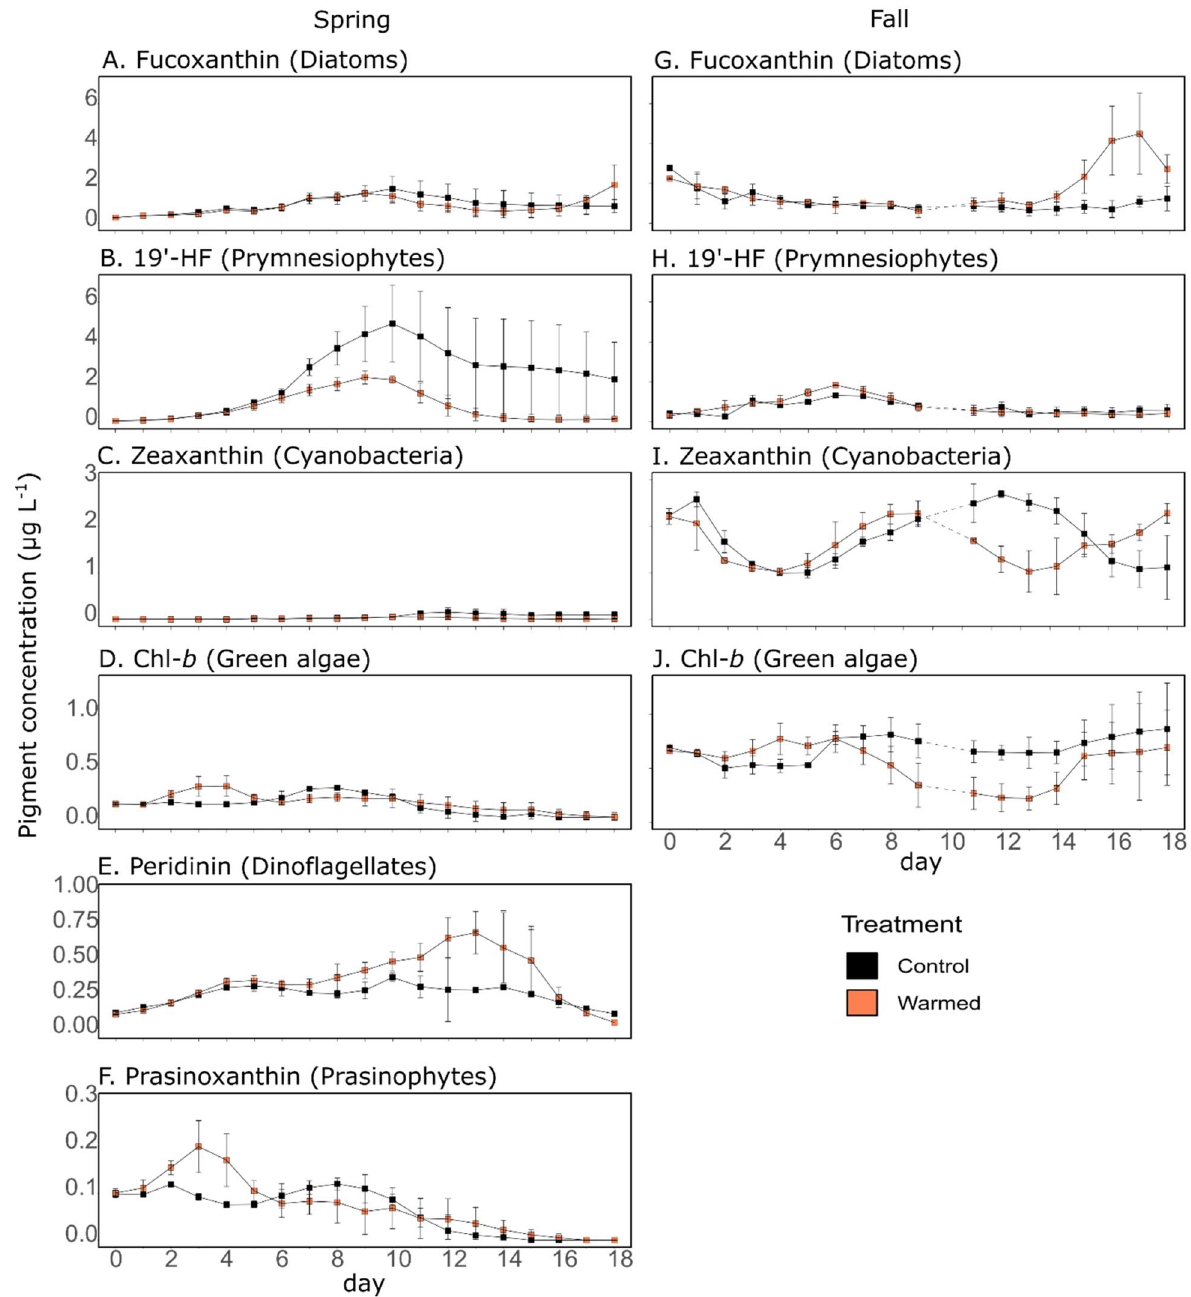
Figure 4. Phytoplankton pigment concentrations. Daily pigment concentrations (µg L −1 ) in the control (black) and warmed (orange) treatments for the spring ( A – F ) and fall ( G – J ) experiments. Error bars represent range of observation for the two mesocosms per treatment in spring and the standard deviation for the three mesocosms per treatment in fall. Dotted lines represent the missing data on d10 of the fall experiment due to bad weather conditions. ( A , G ) fucoxanthin; ( B , H ) 19 ′ -hexanoyloxyfucoxanthin; ( C , I ) zeaxanthin; ( D , J ) chlorophyll- b ; ( E ) peridinin, and ( F ) prasinoxanthin. Corresponding phytoplankton functional groups are indicated in and the specific accessory pigment prasinoxanthin (0.06 ± 0.01 µg L −1 ), which are associated with dinoflagellates, green algae, cyanobacteria, and prasinophytes, respectively (Figs. 4C–F,I,J) 23–25 . In the fall control treatment, the dominant pigments were the cyanobacteria-associated zeaxanthin (1.78 ± 0.22 µg L −1 ), the diatom-associated fucoxanthin (1.07 ± 0.27 µg L −1 ), the green algae-associated Chl- b (0.69 ± 0.14 µg L −1 ), and the prymnesiophyte-associated 19 ′ -HF (0.68 ± 0.16 µg L −1 ). Among the main pigments that were identified in the spring experiment, peridinin and prasinoxanthin were either not detected or detected